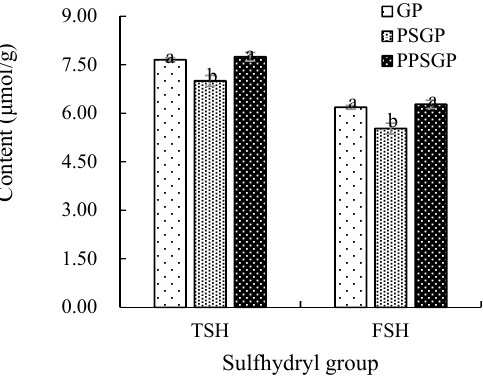
Figure 4. Sulfhydryl content of GP isolate. TSH: total sulfhydryl; FSH: free sulfhydryl. Different letters indicate significant differences.